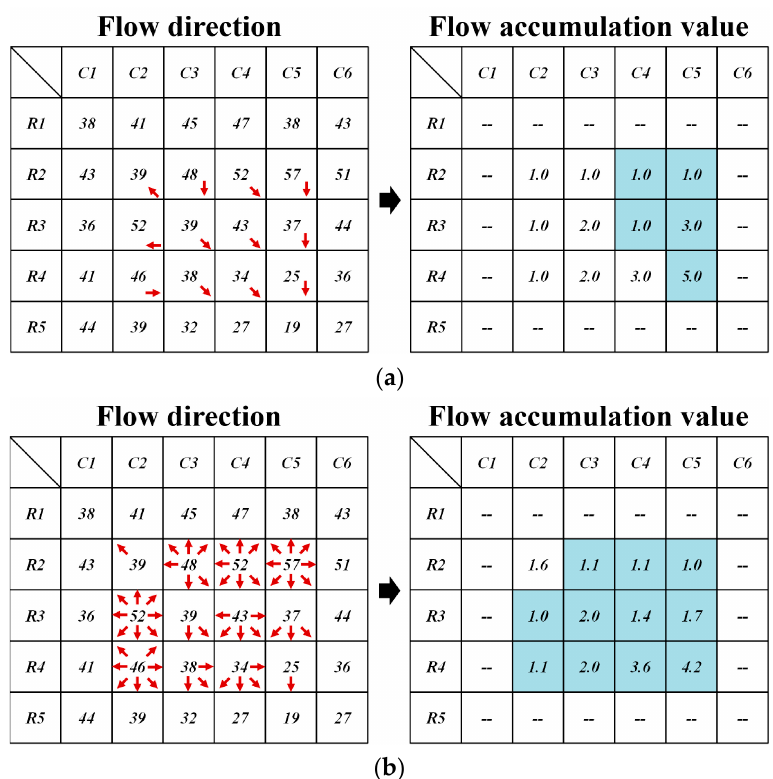
Figure 4. Calculations of two area indexes based on different flow-direction methods: ( a ) D8 method; ( b ) MD8 method.